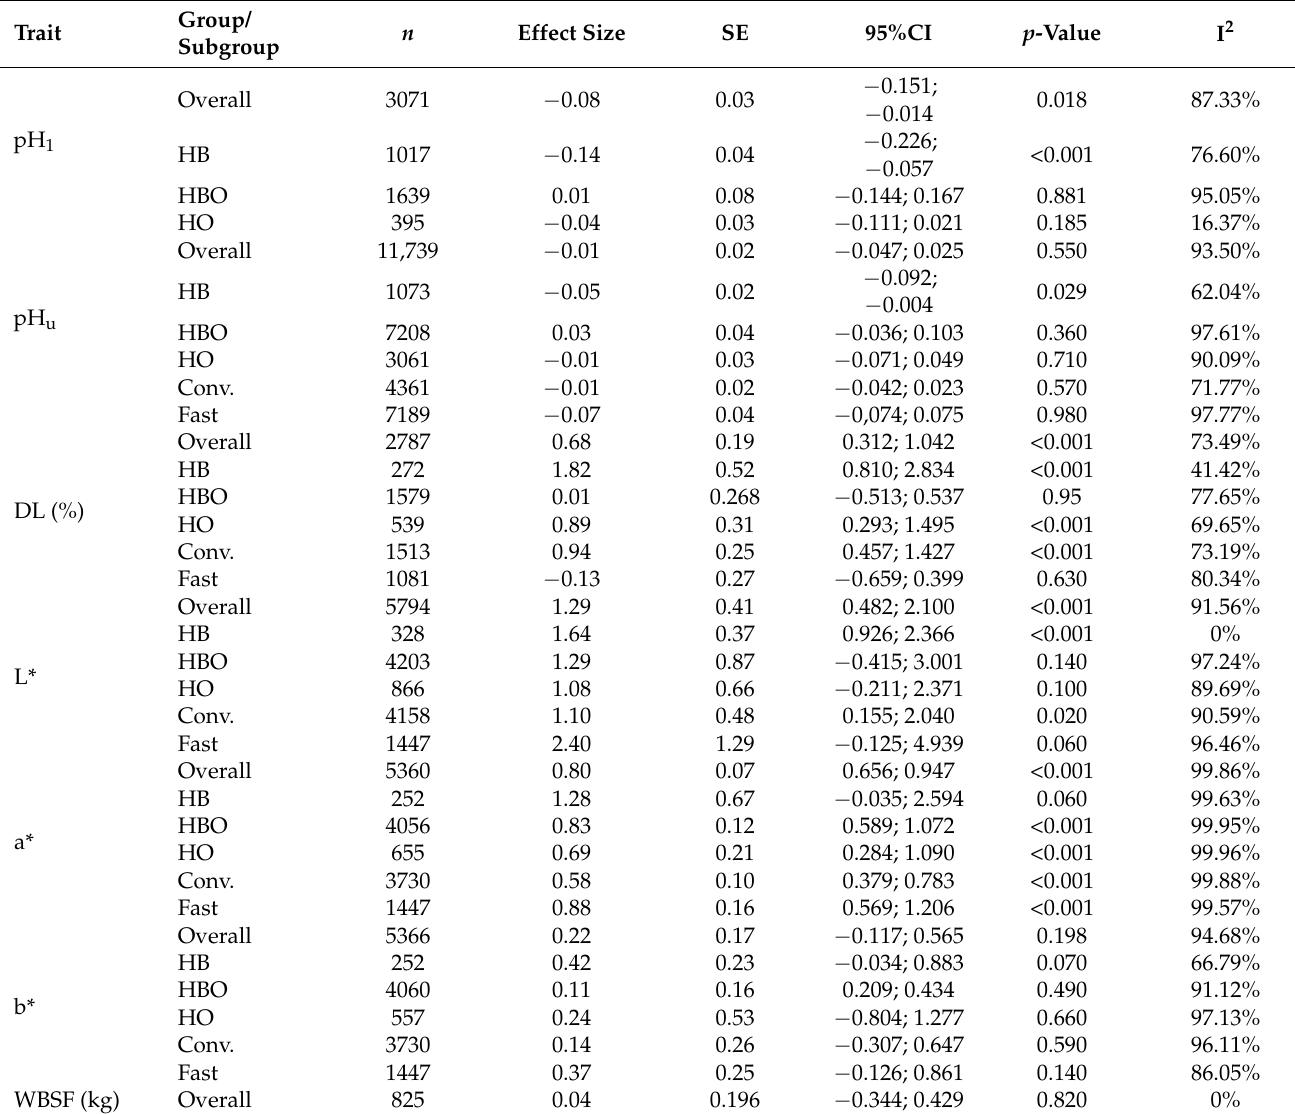
Table 3. Summary of the effect sizes of the stunning (electrical vs. CO 2 ) on analysed pork quality traits in random-effect